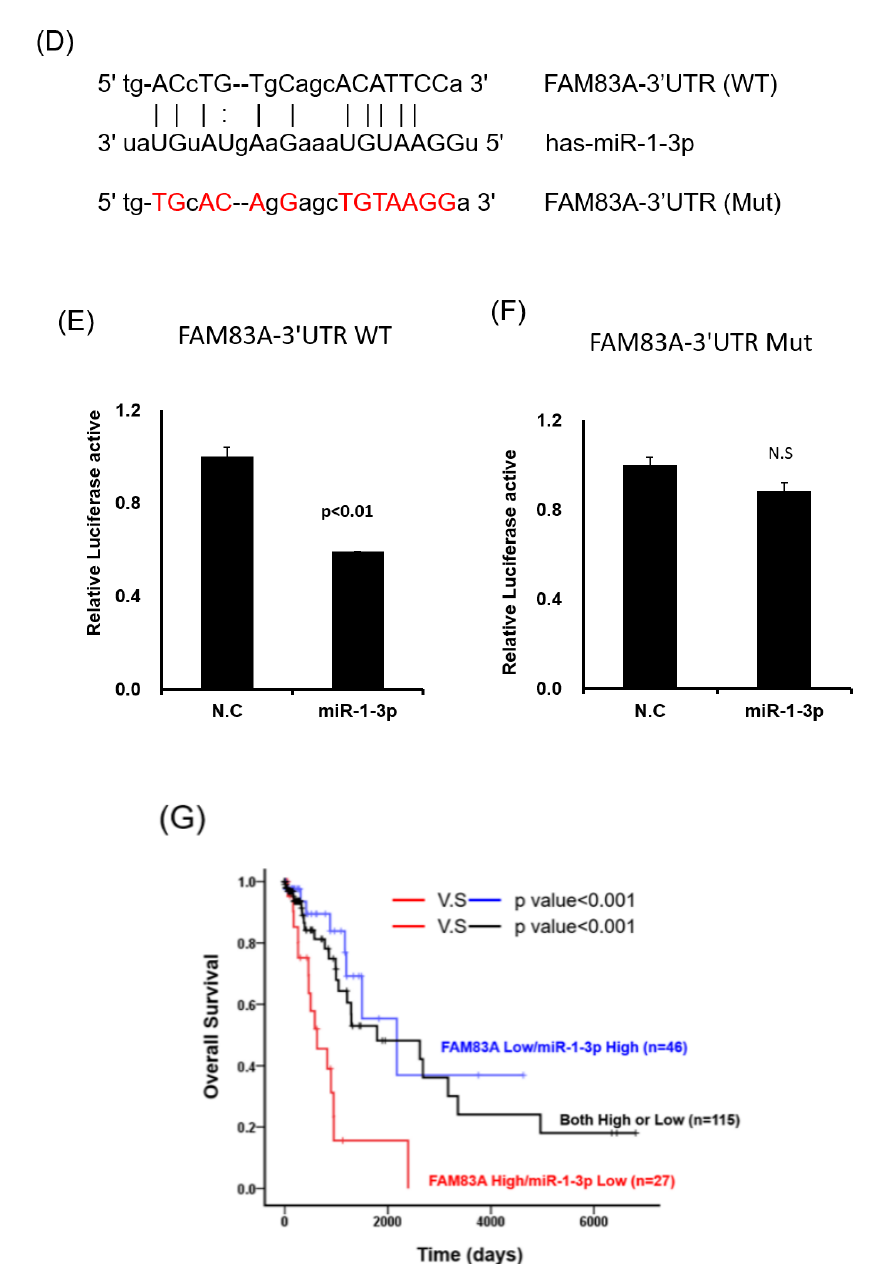
Figure 7. Suppression of FAM83A expression by miR-1-3p through direct binding to the 3′ untranslated region (3′UTR) of FAM83A . ( A ) miR-1-3p expression in lung cancer cells with miR-1-3p mimic transfection. ( B ) FAM83A mRNA expression in lung cancer cells with miR-1-3p and negative control transfection. ( C ) FAM83A protein expression in lung cancer cells with miR-1-3p and negative control transfection. ( D – F ) Reporter construct with wild-type FAM83A 3′UTR or binding site mutant after miR-1-3p cotransfection into lung cancer cells, followed by assessment of luciferase activity. ( G ) Effects of combined FAM83A and miR-1-3p expression on overall survival in lung cancer. N.C. indicates a random siRNA sequence control. All experiments were performed in triplicate, and the data were analyzed using Student’s t test. Differences were considered significant when p < 0.05.